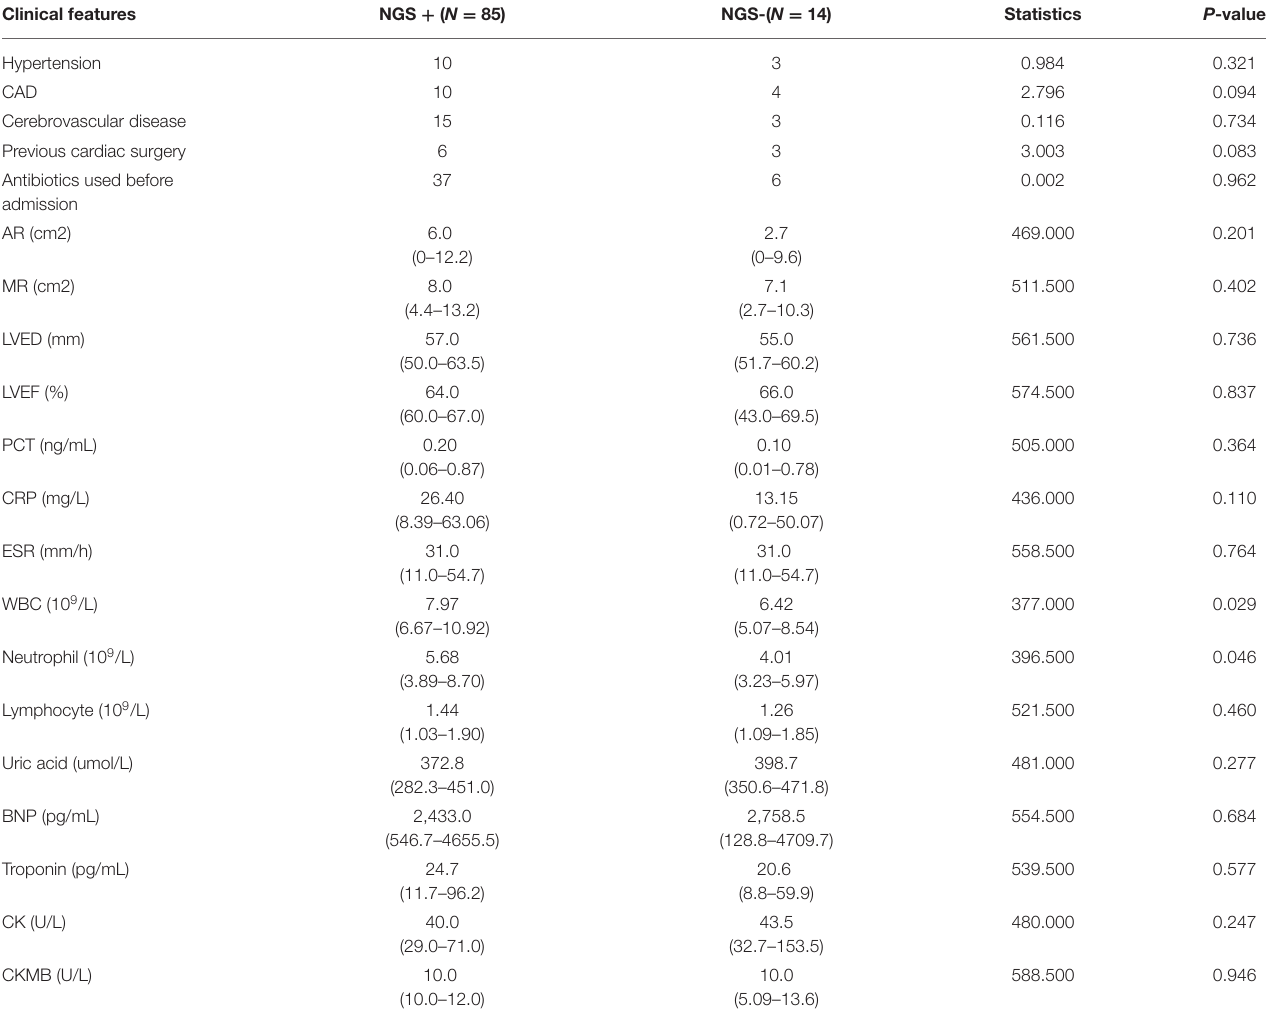
TABLE 3 | Univariate analysis of baseline clinical features that associated with NGS detection ability. Clinical